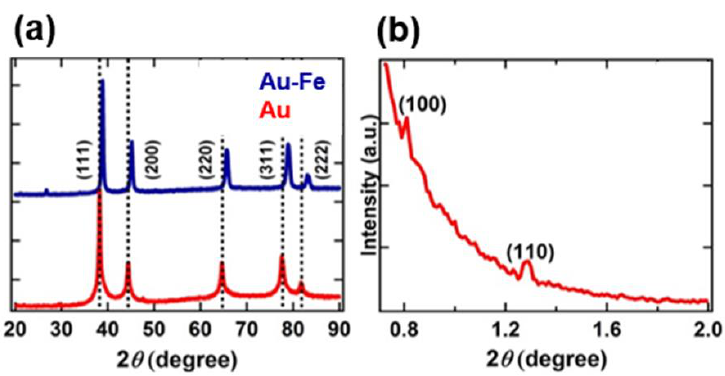
Figure 1. p XRD profiles for Au nanoparticles and the nanoporous Au-Fe alloy in high reflection ( a ) and low reflection angles ( b ).